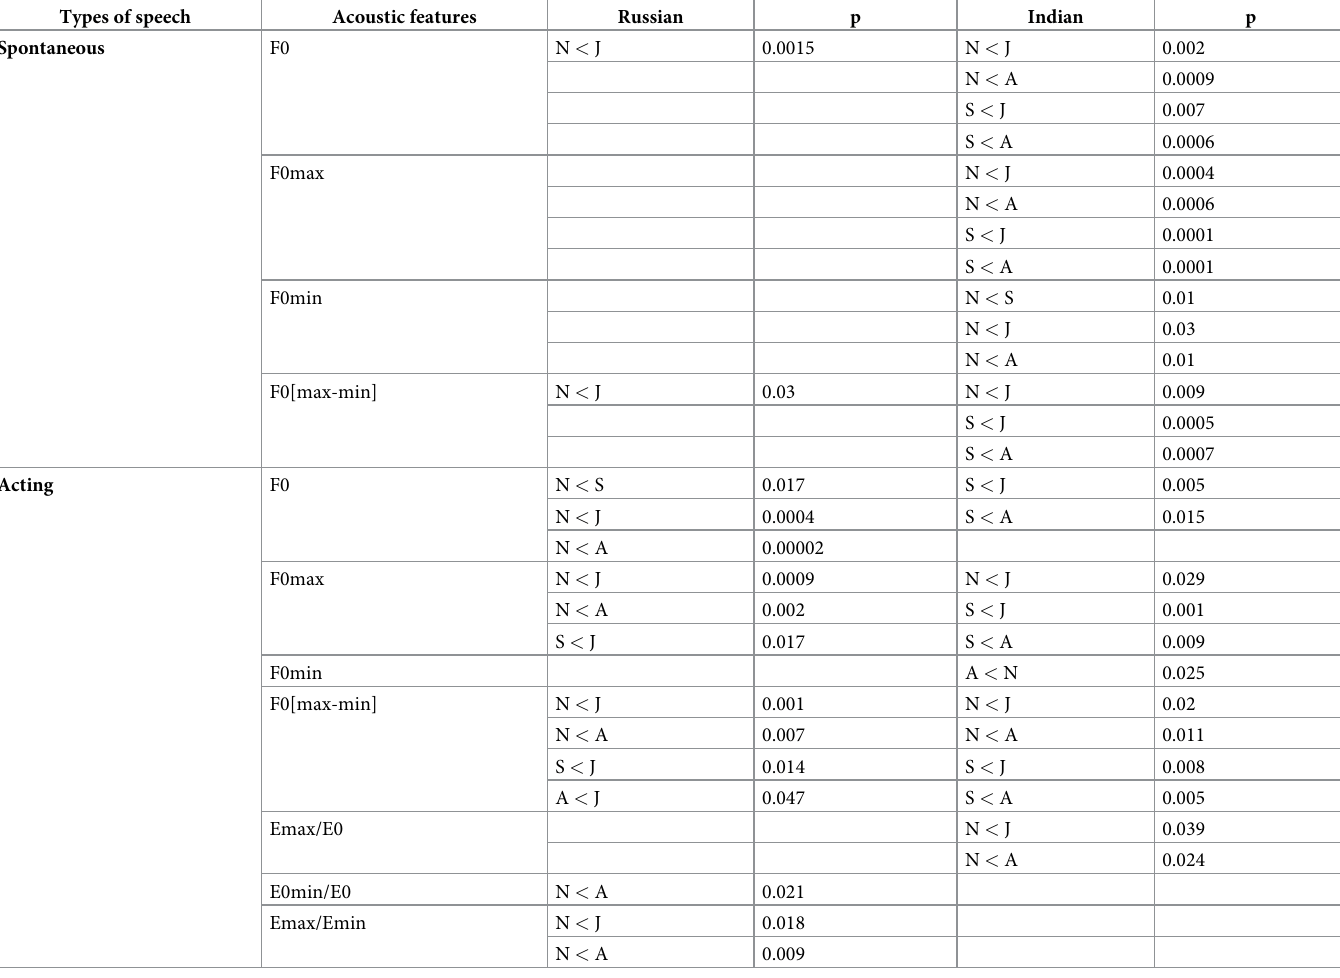
Table 14. Significant differences between acoustic features of the emotional speech of Russian children correctly (range 0.75–1.0) classified by Russian experts and acoustic features of the emotional speech of Indian children correctly classified by Indian